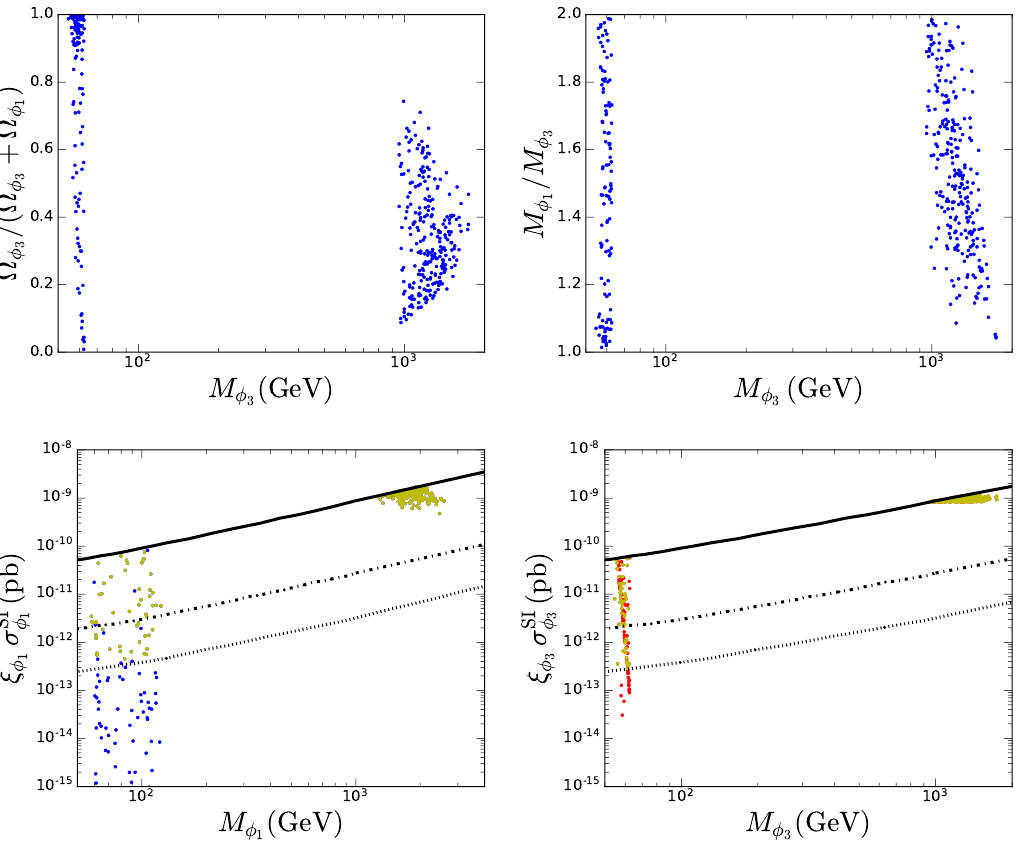
Figure 7 . A sample of viable points of the Z 6 model with ( φ 1 , φ 3 ) and M φ along different dimensions. The top panels show scatter plots of M φ versus the ratio of dark matter masses (right). The direct detection prospects are shown in the bottom panels for φ 1 (left) and φ 3